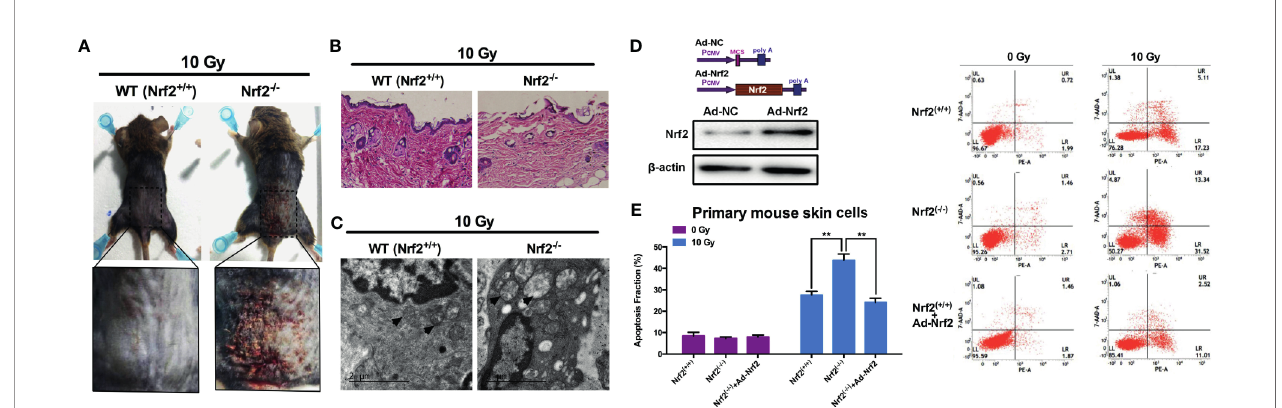
FIGURE 1 | Increased susceptibility to radiation-induced skin injury in Nrf2-de fi cient mice. (A) Radiation-induced skin injury induced by 10 Gy electron beam radiation in WT (Nrf2 +/+ ) and Nrf2-de fi cient (Nrf2 -/- ) mice. (B) HE staining of skin tissues in irradiated areas from WT (Nrf2 +/+ ) and Nrf2-de fi cient (Nrf2 -/- ) mice. (C) Electron microscopy analysis of skin tissue from WT (Nrf2 +/+ ) and Nrf2-de fi cient (Nrf2 -/- ) mice. Scale bar=2 m m. (D) Nrf2 was overexpressed after Ad-Nrf2 treatment. (E) Cell death rate of primary skin cells from WT (Nrf2 +/+ ) and Nrf2-de fi cient (Nrf2 -/- ) mice after Nrf2 overexpression and 10 Gy irradiation. ** means p <